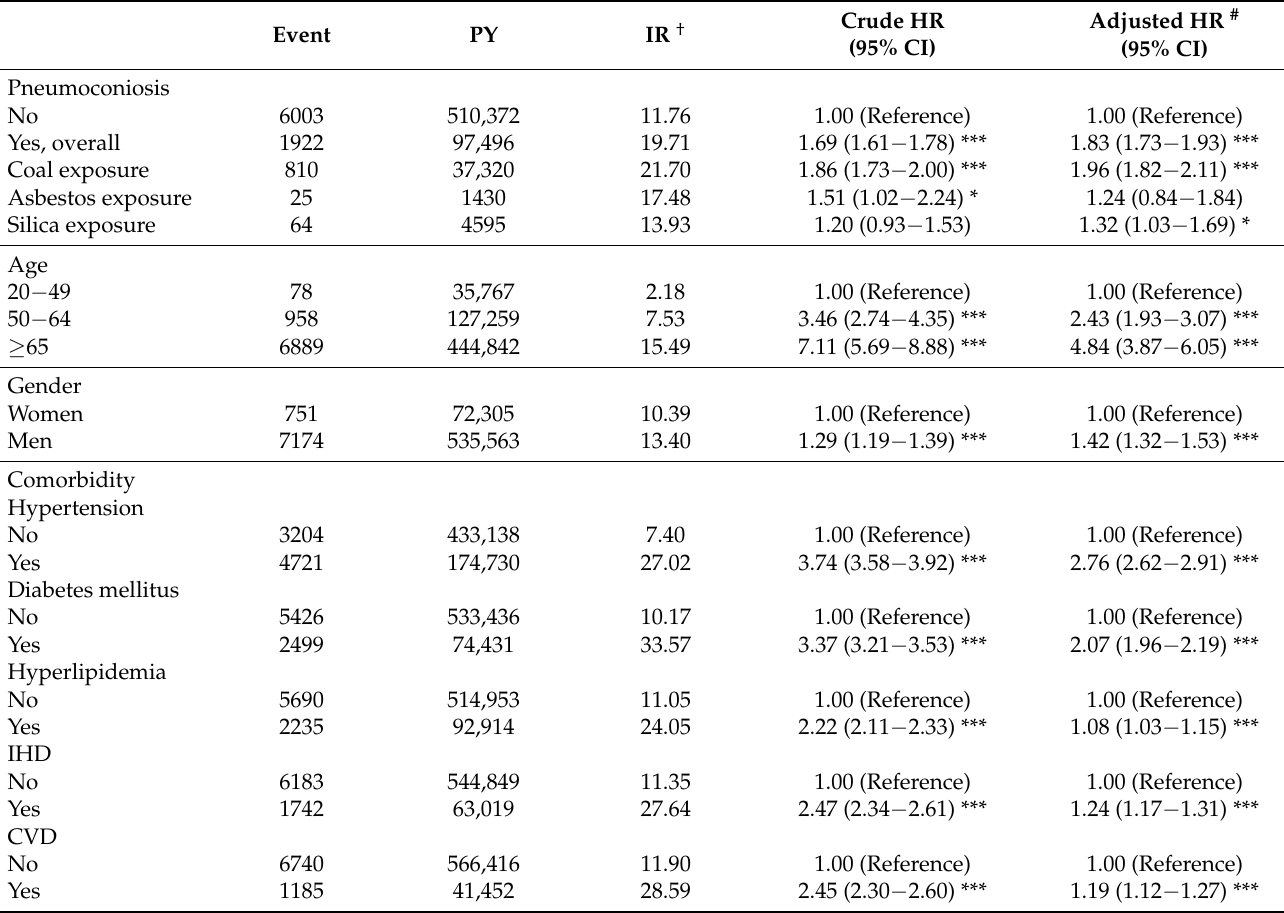
Table 2. Risk factor analyses for chronic kidney disease among all study individuals.